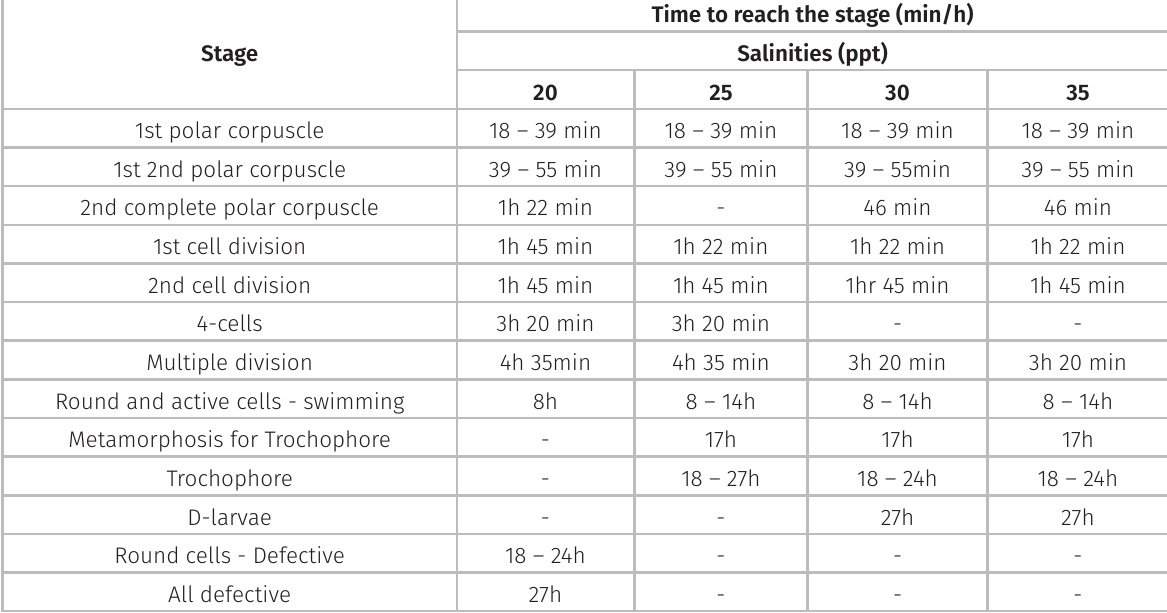
Table I. Embryonic development description of Mesodesma mactroides in different salinities: 20, 25, 30 and 35 ppt, in the period of 27 hours. Average number of individuals per treatment = 10. Mean of water temperature (± SD), during experimental period, 21.0 ± 0.9